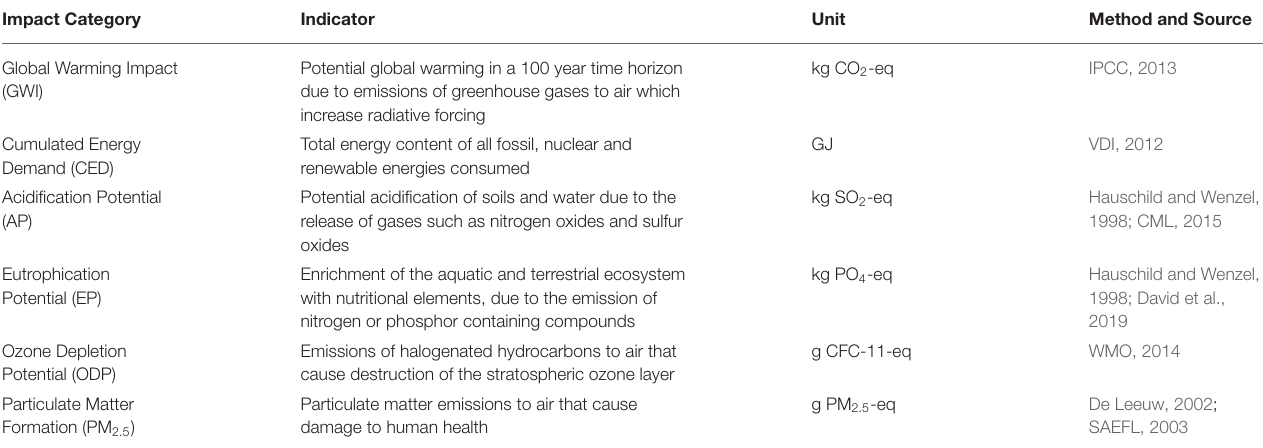
TABLE 1 | Impact categories used for the LCIA, relevant indicators, and underlying